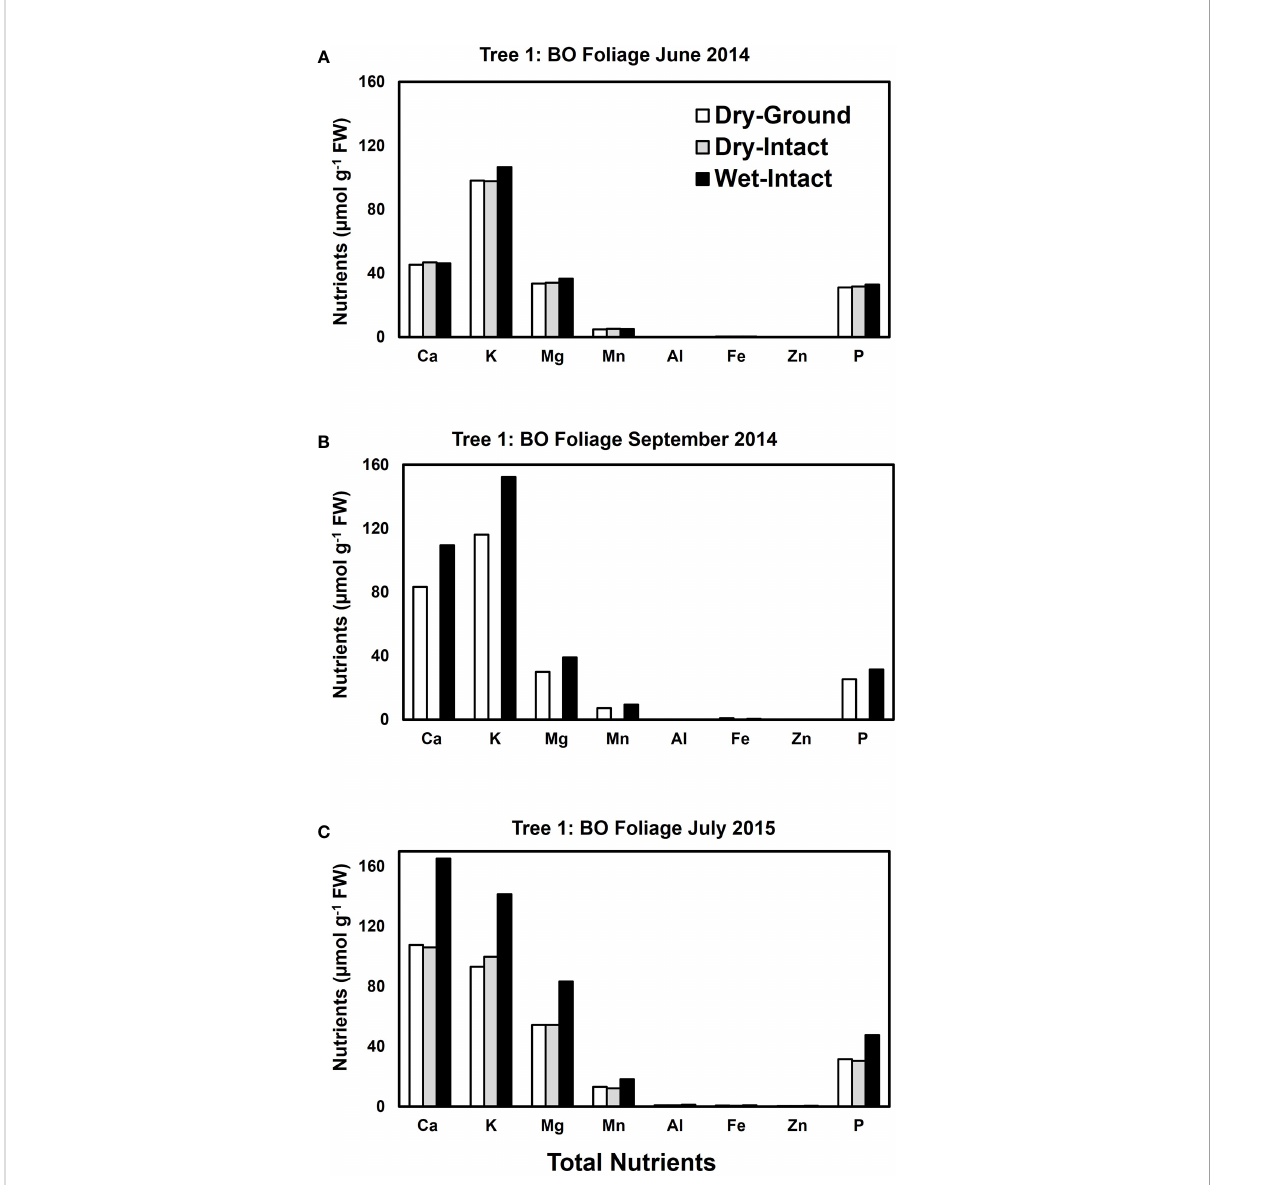
FIGURE 3 Comparison of three tissue preparation methods for the extraction of total inorganic nutrients from black oak foliage. Data presented here are from three collections from a single tree in: June 2014 (A) ; September 2014 (B) ; and July 2015 (C)